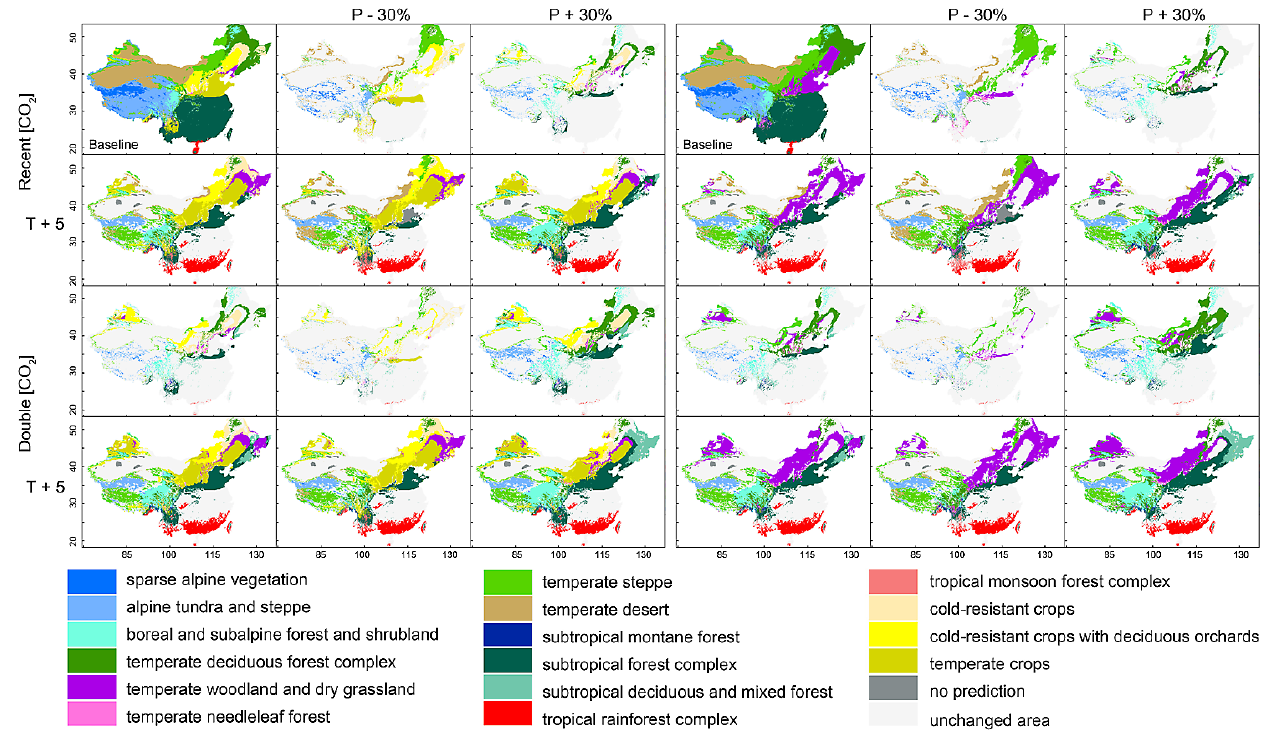
Fig. 5. Changes in predicted vegetation distribution at projected scenarios, with a reference distribution at the baseline scenario (left panels for both natural and agriculture vegetation types, right panels only for natural vegetation